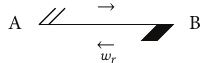
Figure 2: Scattering bond.